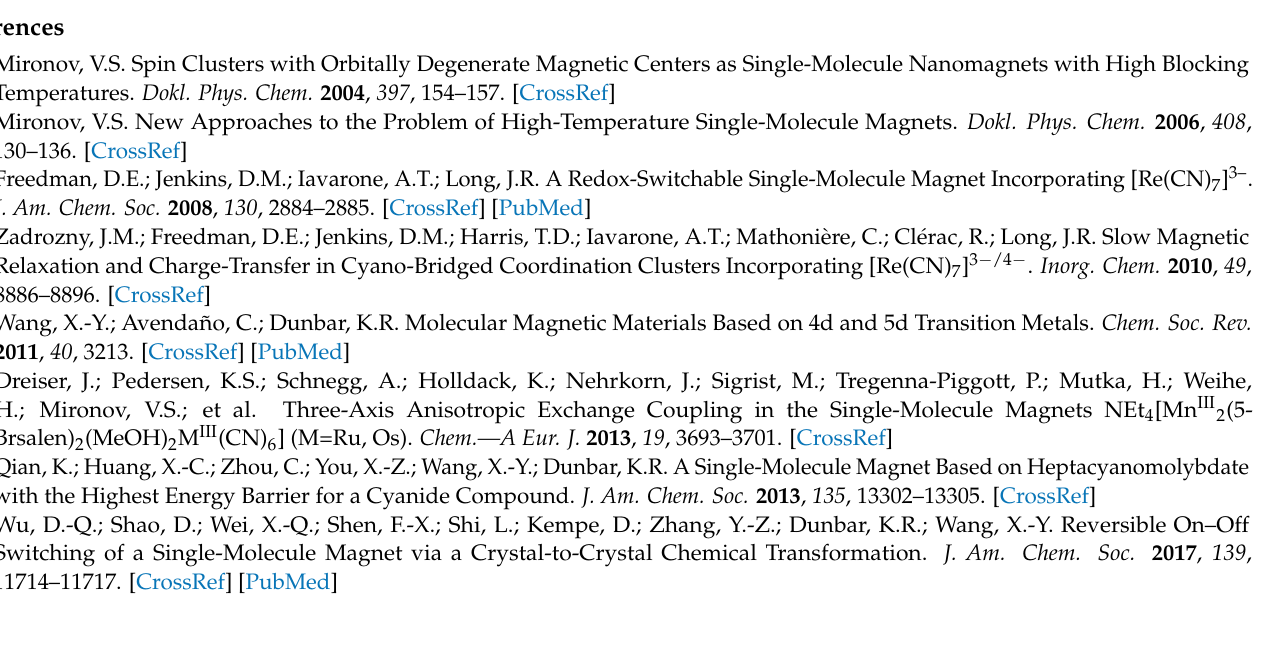
Re-CN equatorial —{MnN 2 O 2 } are colored in olive and red respectively; Figure S11: A view of superimposed in pairs layers in for 1 : the first on the second, the second on the third and the third on the fourth; Figure S12: PXRD pattern for the material 1 ; Figure S13: dM/dH plot of 2 for the magnetization data collected at 1.8 K; Figure S14: Initial magnetization plots of 2 measured at different temperatures on a polycrystalline sample; Figure S15: Magnetic hysteresis plots of 2 measured at different temperatures. Inset is a zoom of low field region for the data collected at 10 and 16 K; Figure S16: Variable-temperature of the real, χ ’ (top), and imaginary, χ ” (bottom), parts ac molar susceptibility data for 1 under H dc = 100 Oe, H ac = 3 Oe. Solid lines are guides; Figure S17: Variable-temperature of the real, χ ’ (top), and imaginary, χ ” (bottom), parts ac molar susceptibility data for 2 under H dc = 100 Oe, H ac = 3 Oe. Solid lines are guides; Figure S18: Plots of ln(X (cid:48) T ) vs 1/ T (where X (cid:48) is a real component of the ac susceptibility for 1 collected in applied dc field of 100 Oe, H ac = 3Oe and frequency of 0.56 Hz. The dashed lines correspond to a linear fit.; Figure S19: Plots of ln( χ (cid:48) T) vs 1/ T (where χ (cid:48) is a real component of the ac susceptibility for 2 collected in applied dc field of 100 Oe, H ac = 3Oe and frequency of 0.56 Hz. The dashed lines correspond to a linear